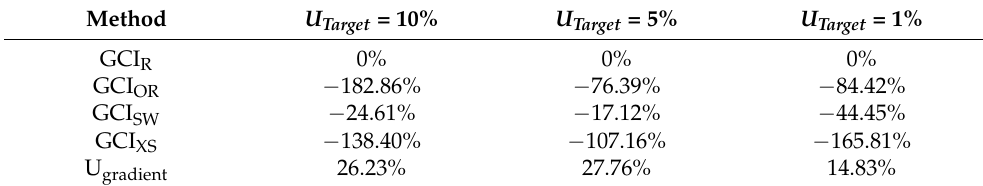
Table 4. Average Computational Time Saving Compared to Roache’s Method.